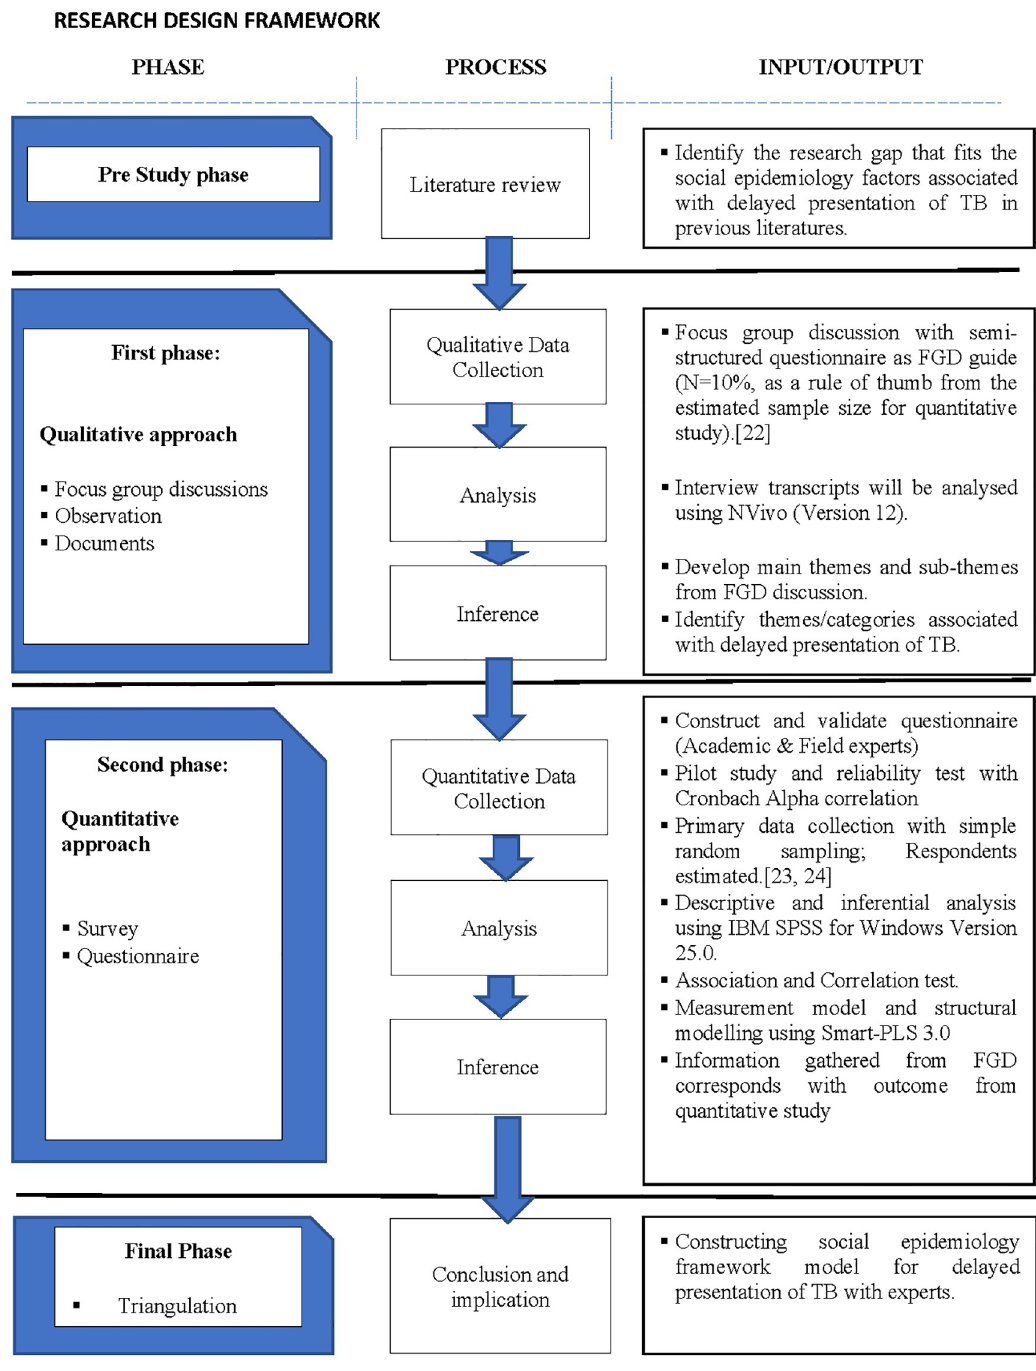
Fig 1. Research design of the different study phases.